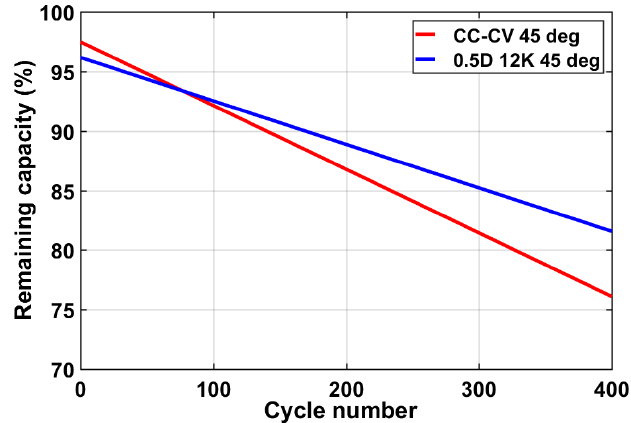
Figure 13. Cycle life comparison of CC-CV charged battery and pulse charged battery.